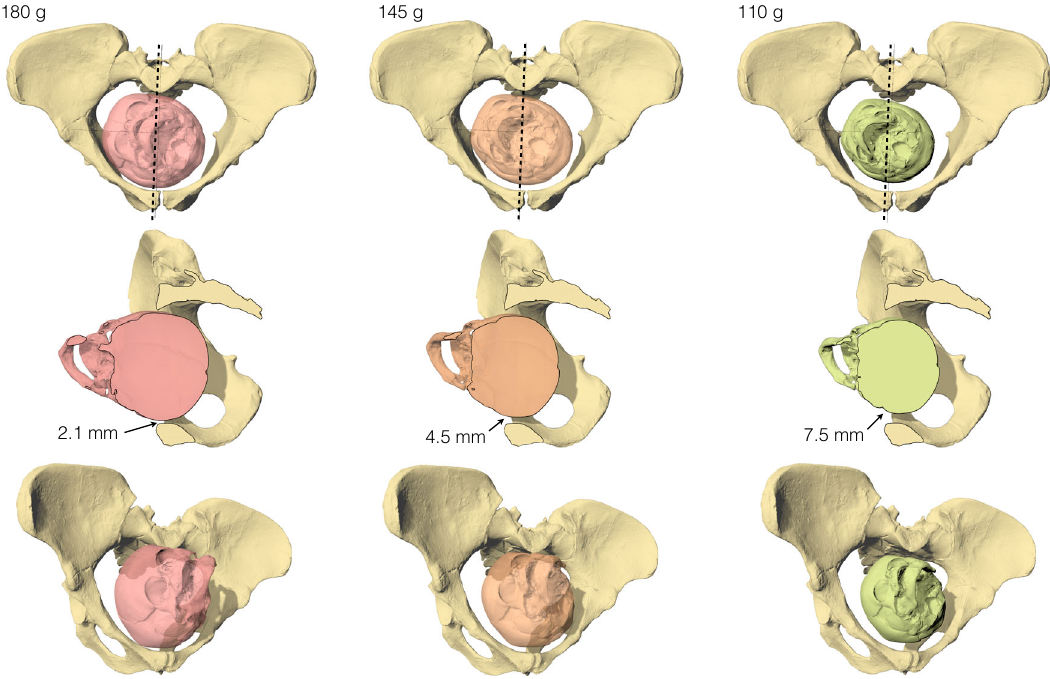
Fig. 4 Engagement of the fetal head in the pelvic inlet of A.L. 288-1, pelvic reconstruction of Häusler and Schmid 19 . The in silico simulation shows that only the 110 g fetal head size leaves suf fi cient space (i.e., >7 – 10.6 mm) for fetopelvic soft tissue. The best cephalopelvic fi t is obtained with a slightly oblique head presentation at the pelvic inlet, and the maximum constriction occurs in a para-sagittal plane (dashed line). Top row: view perpendicular to pelvic inlet. Middle row: right lateral view, clipped at the plane of maximum constriction; the fi gures indicate the width of the gap between the fetal skull and the maternal pelvis. Bottom row: oblique perspective